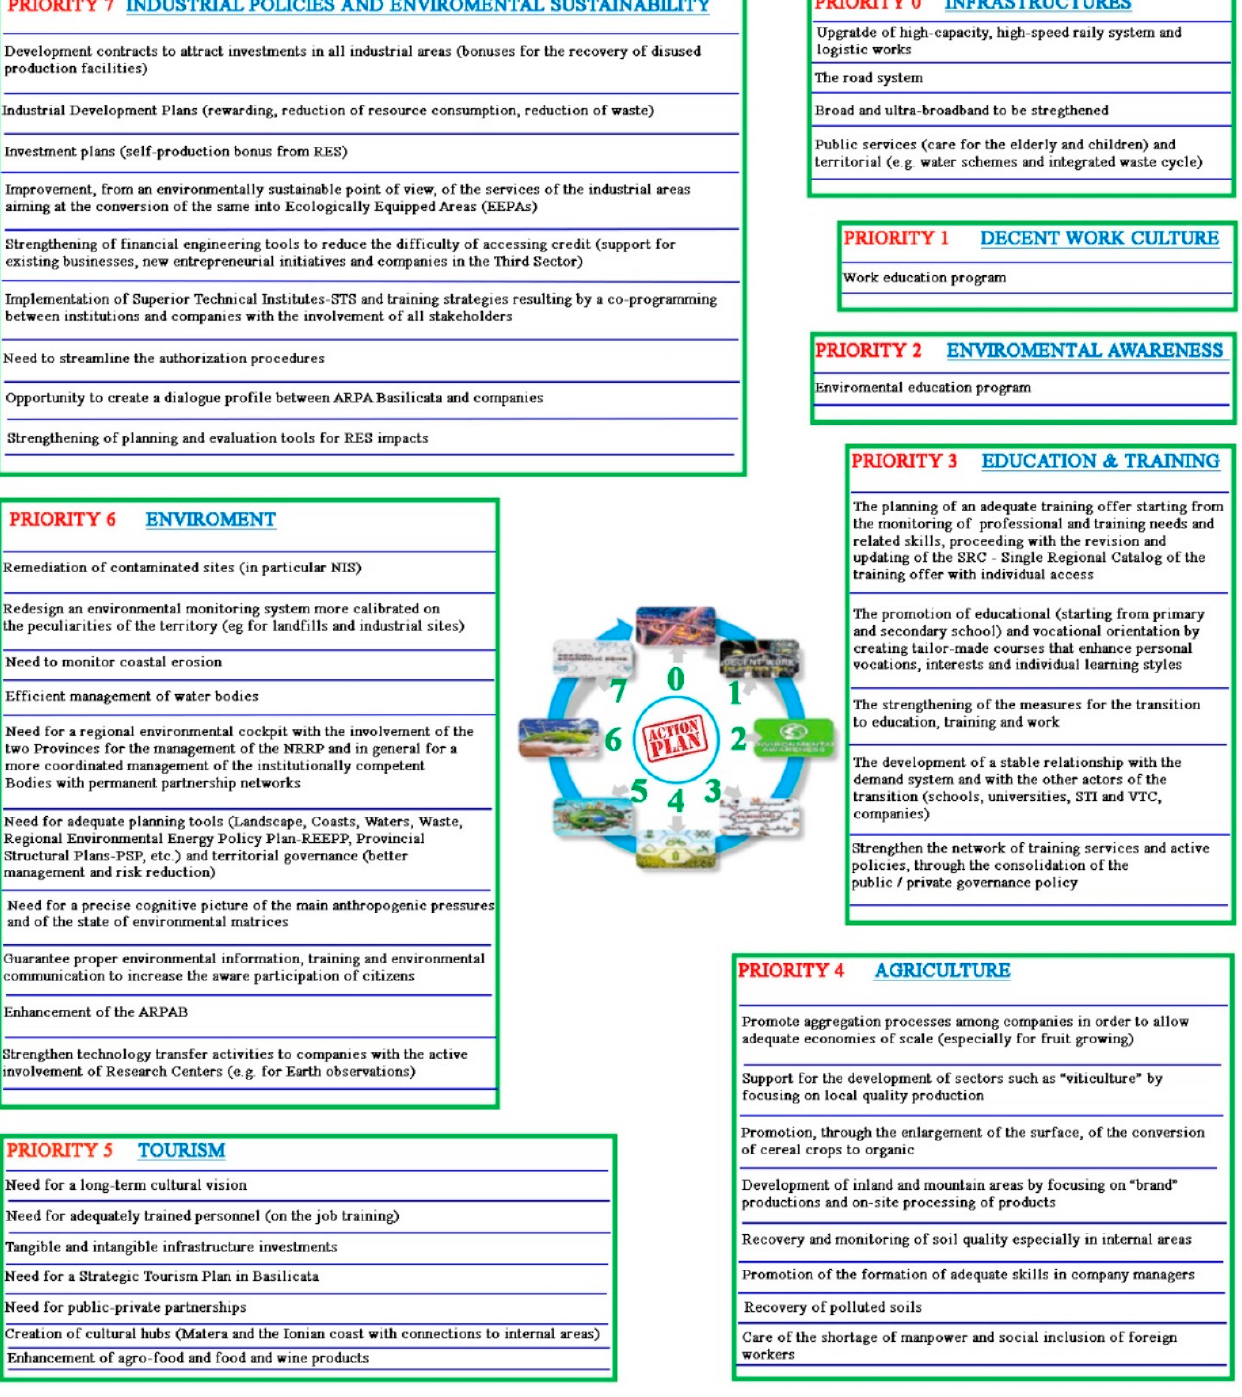
Figure 10. The action plan containing the strategic actions for each priority individuated as outputs of the participatory planning process.